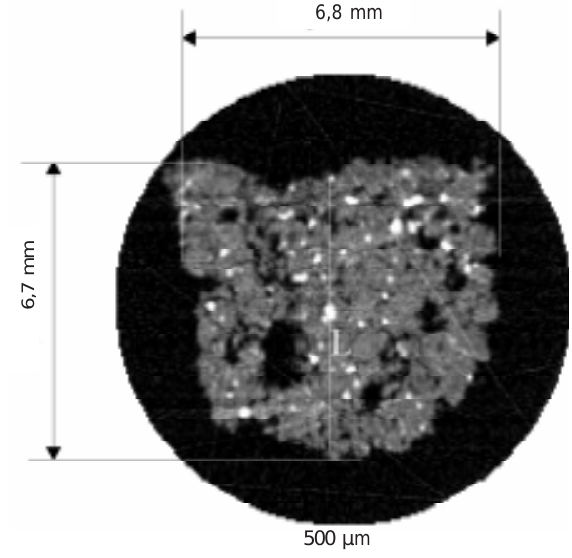
Figura 7. Microtomografia de um fragmento de torrão de solo, onde podem ser vistos poros de 200 a 800 mmmmm m e pontos de alta atenuação, invisíveis em tomografia de resolução milimétrica. O valor máximo de densidade das partículas encontrado foi de 4,005 g cm -3 .